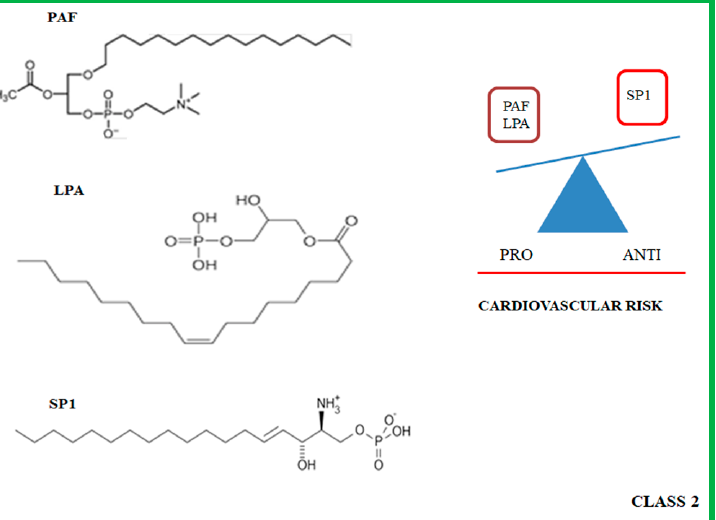
Figure 2. Molecular structure of the principal class 2 lipid mediators (on the left ). On the right, the class 2 lipid mediators are divided according to their anti- and pro-cardiovascular risk properties.